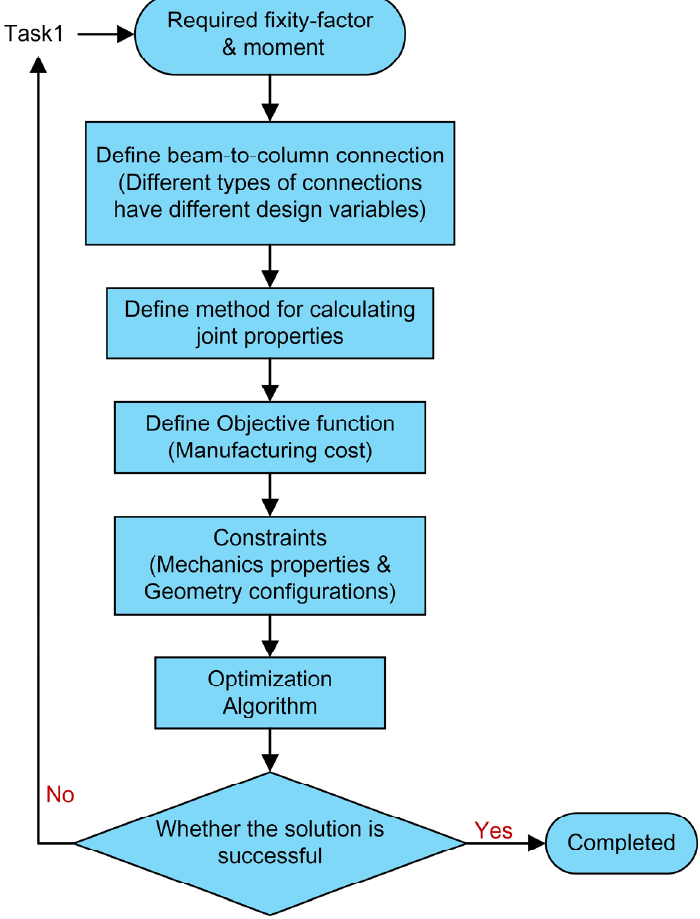
Figure 4. The workflow for reconstructing joint details subject to required performance.